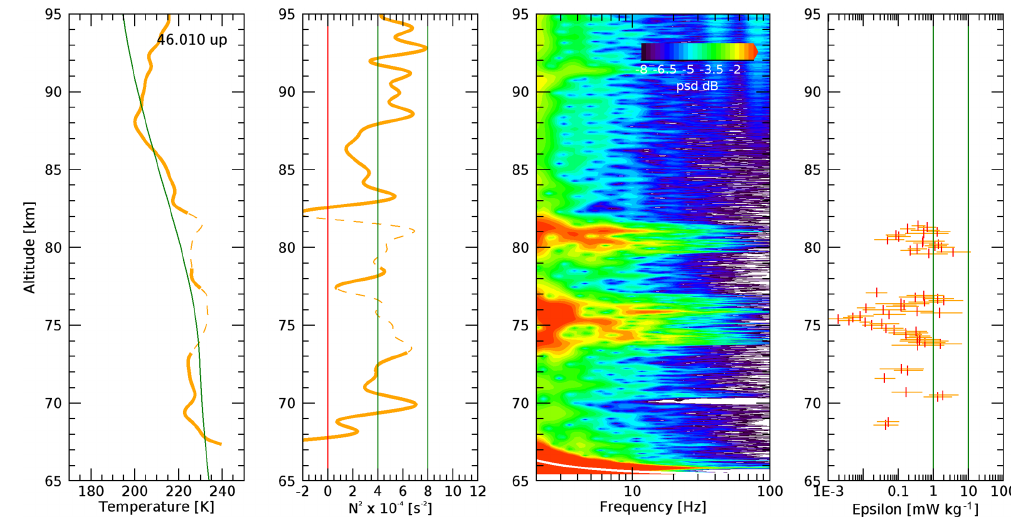
Figure 11. Same as Fig. 9 but for 46.010